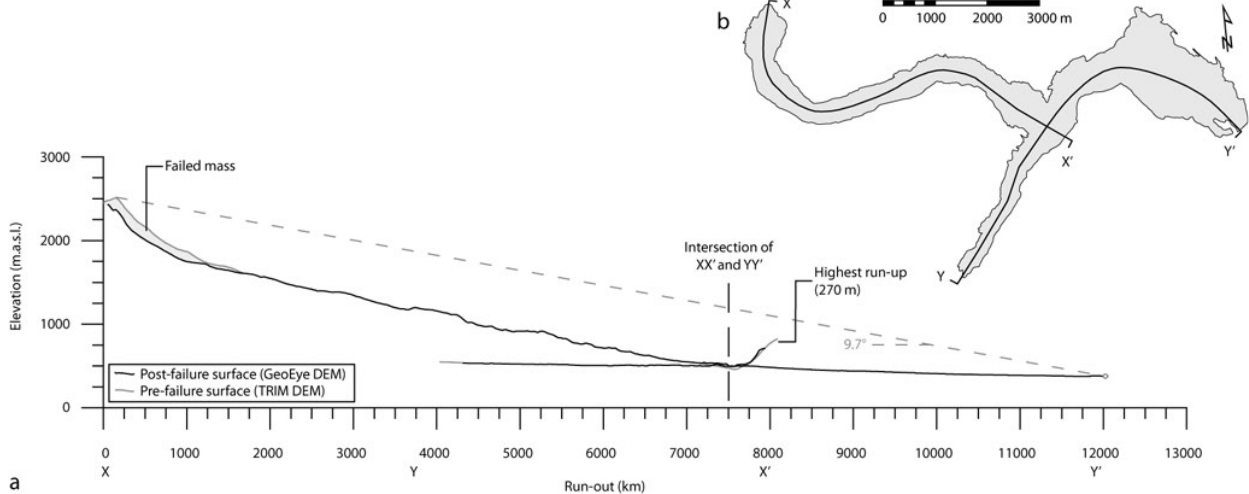
Fig. 3. Profile of the Mount Meager landslide.